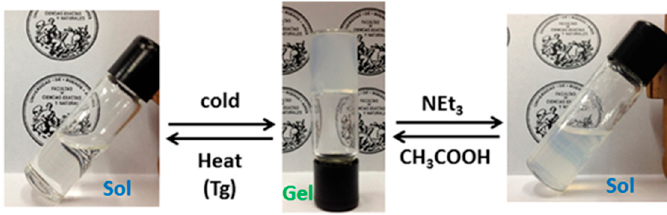
Figure 8. Thermic and pH triggered sol-to-gel and gel-to-sol transitions of organogelator 3 in methanol.